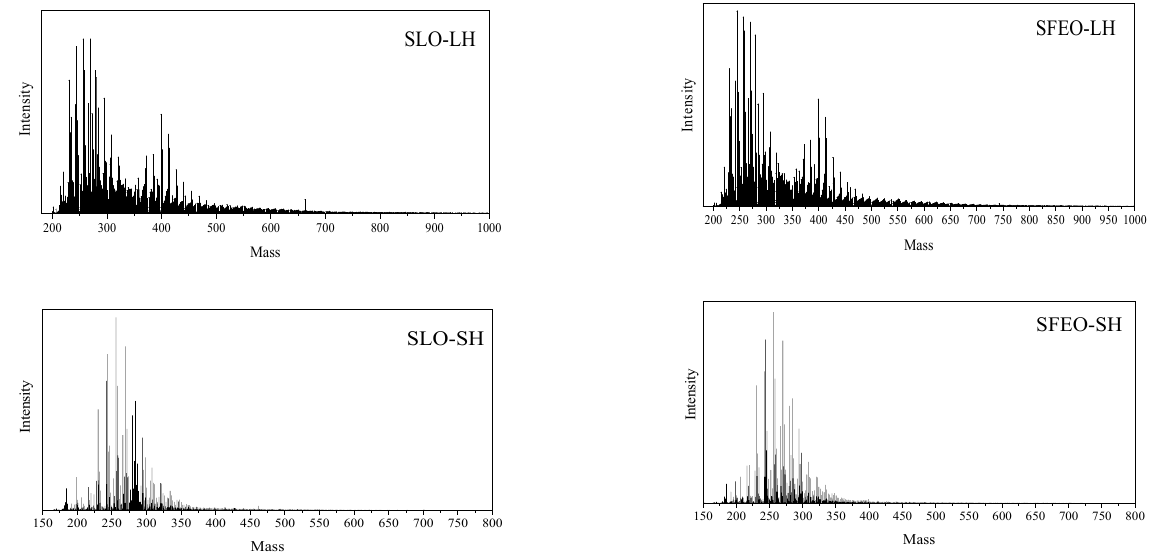
Figure 5. Mass spectra of SLO and SFEO were obtained by FT-ICR MS (APPI).